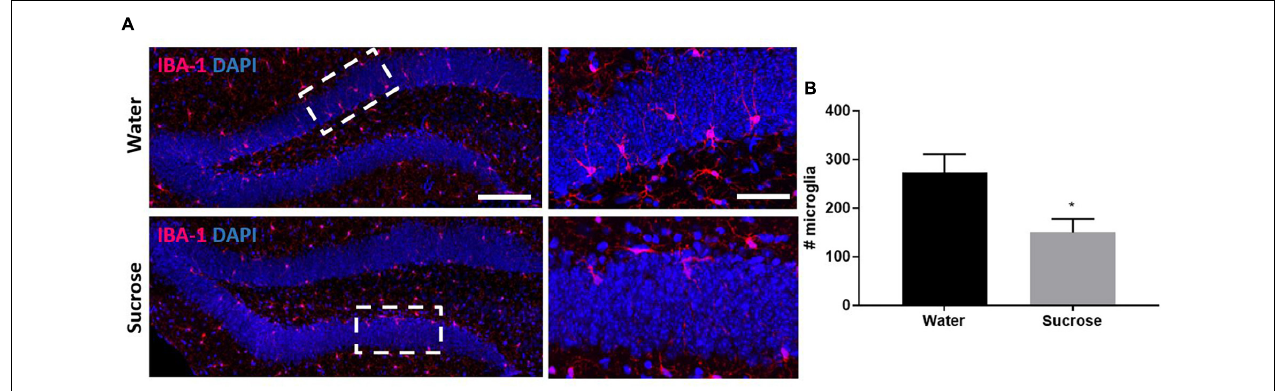
FIGURE 4 | Sucrose consumption alters microglia in the dentate gyrus of the hippocampus. (A) Representative images at both 4 × (left images; scale bar = 100 µ m) and 40 × magnification (field indicated by white boxes on 4 × magnification images; right images; scale bar = 10 µ m). (B) Long-term sucrose consumption reduces the number of microglia (magenta) in the DG of the hippocampus. All images are co-localised with DAPI (blue). Data are presented as mean ± S.E.M ( t -test); n = 8 mice/group. * p <